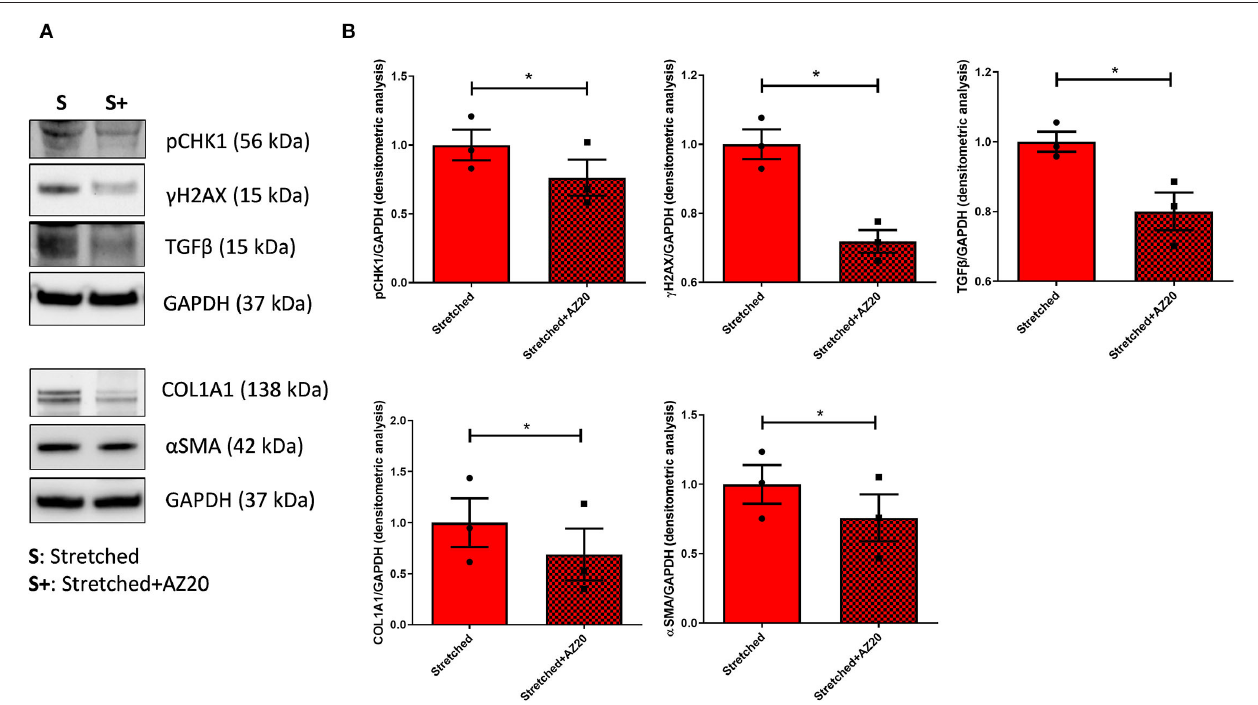
FIGURE 5 | DDR inhibitor AZ20 prevents pro-fibrotic commitment. (A) Western blots of γ H2AX, pCHK1, COL1A1, TGF β , and α SMA from stretched HC C-MSC treated with/out AZ20. Immunostaining of the housekeeping GAPDH is shown for each gel for normalization. (B) Densitometric analyses of γ H2AX, pCHK1, COL1A1, TGF β , and α SMA levels, normalized on the corresponding GAPDH. * p <